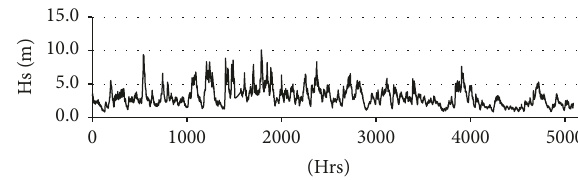
Figure 1: Plot of the September–April Hs time series of 01-02.